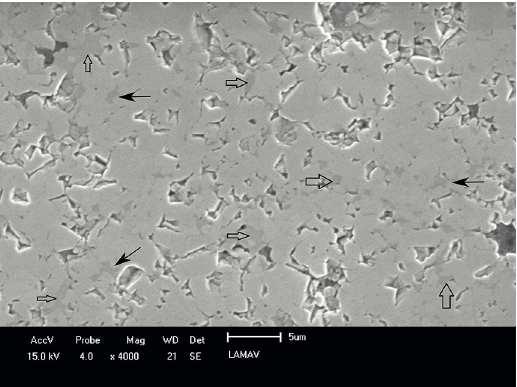
Figure 4. Structure of alloy REF. Region far from a Co particles. Boundaries of WC Grains with some Co binder and pores are seen.